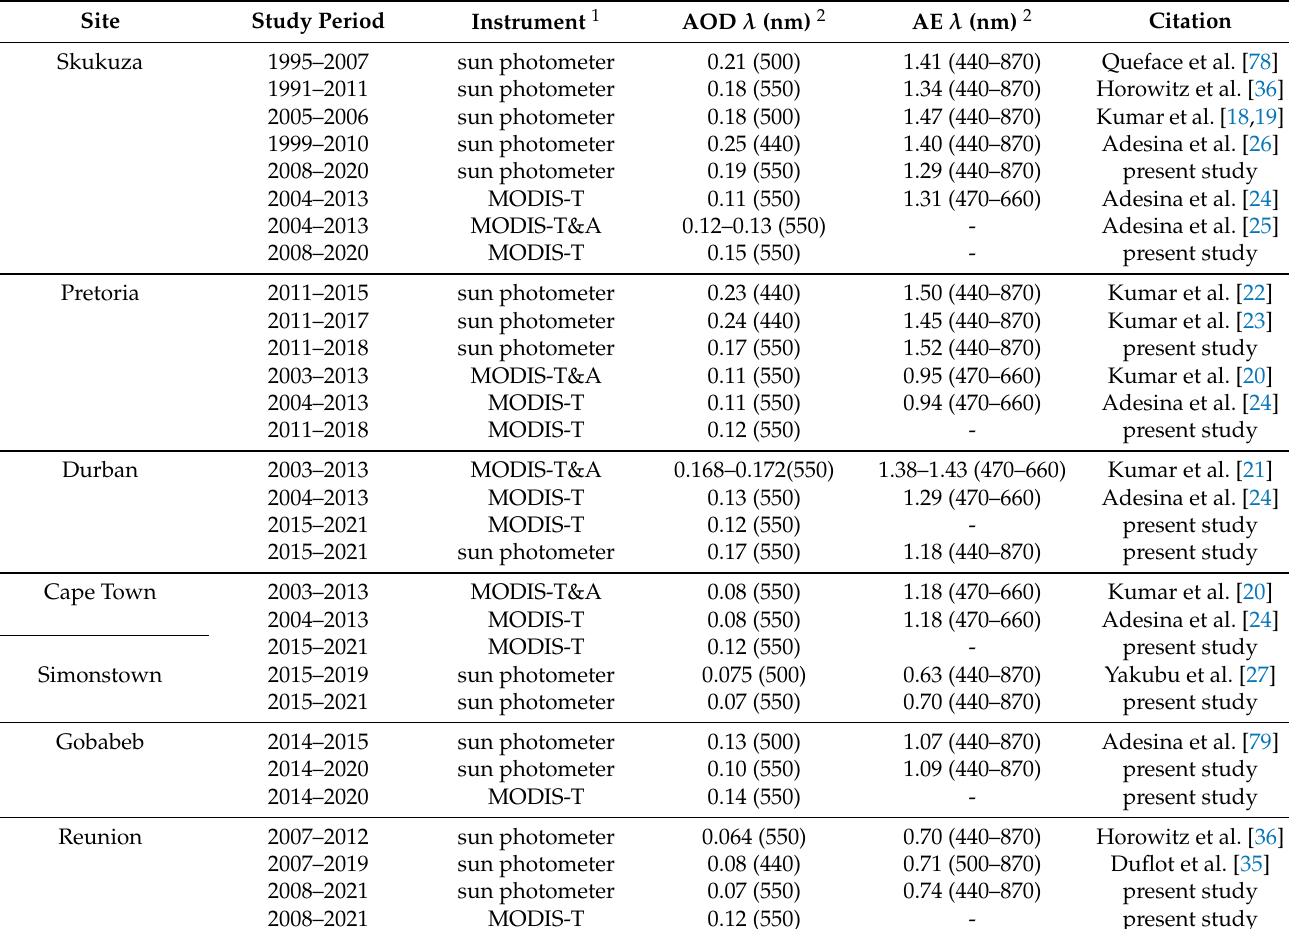
Table A1. Comparison of aerosol optical depth (AOD) at Southern Africa sites